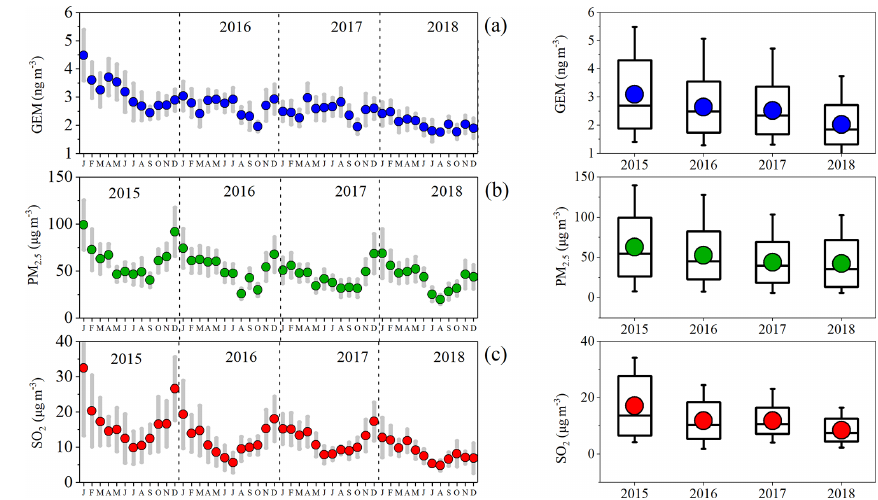
Figure 2. Monthly and annual variations in (a) GEM, (b) PM 2 . 5 , and (c) SO 2 concentrations from 2015 to 2018.